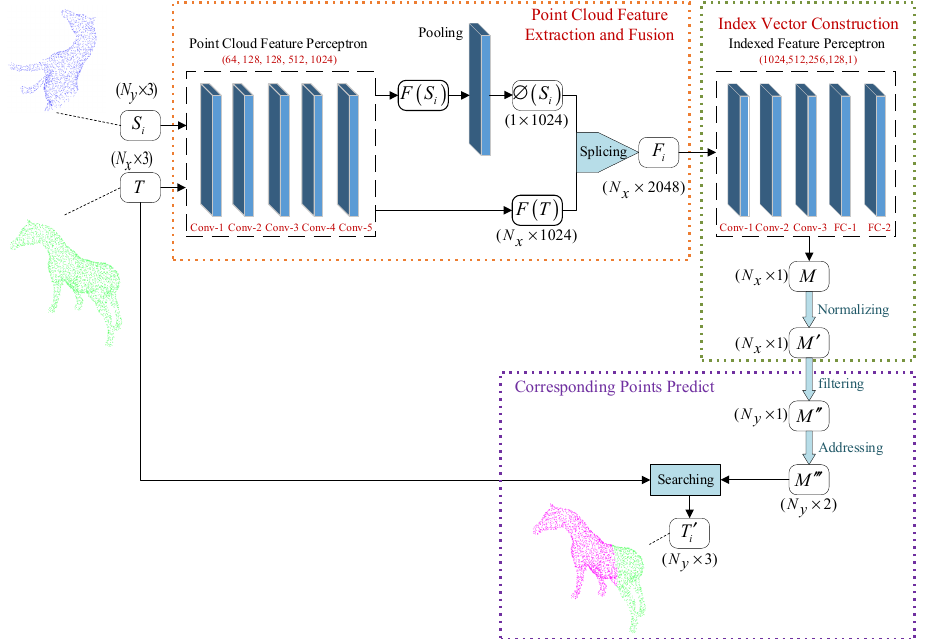
Figure 2. The network architecture of the TPCC-Net.